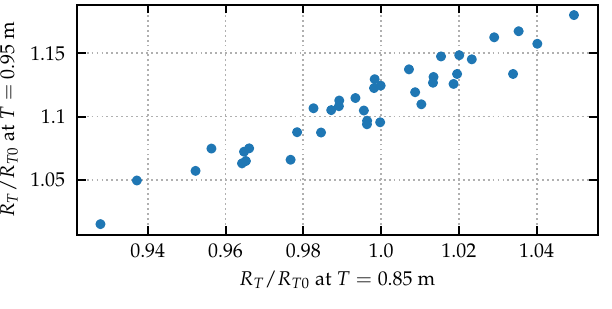
Figure 5. Non-dimensional resistance at design draft vs. non-dimensional resistance at higher